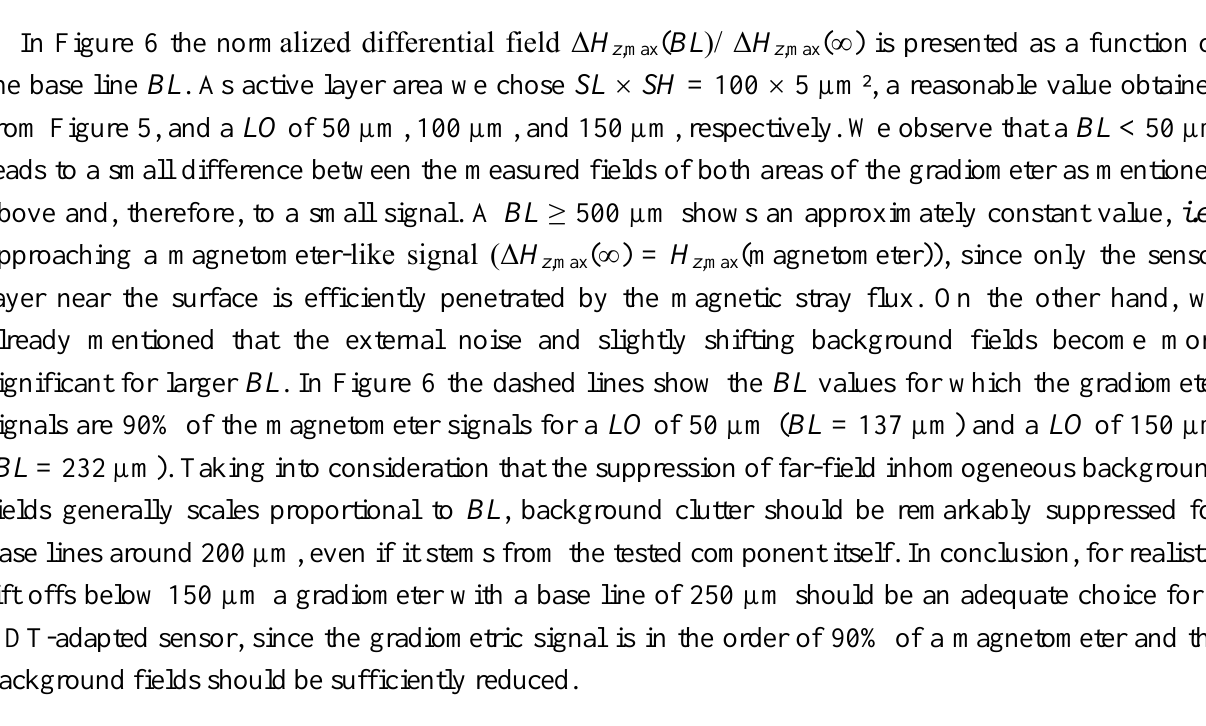
Figure 6. Normalized maximum MFLs as a function of the base line BL for a sensor with dimensions SL  SH = 100  5 µm², and for different LOs . The straight line depicts the case for a gradient field of 90% of the magnetometer signal. Depending on the LO s, this 90% response is obtained for base lines BL = 137 µm ( LO = 50 µm) and BL = 232 µm ( LO = 150